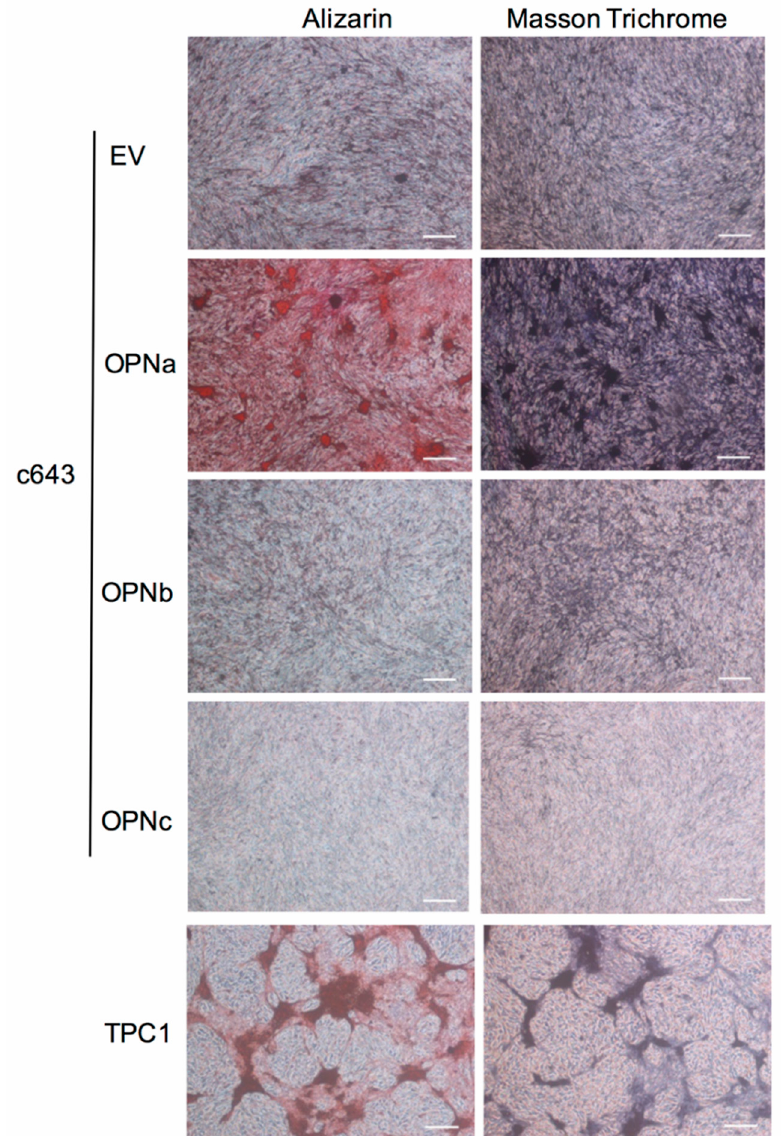
Figure 2. Calcification and collagen production in c643 cell clones and TPC-1 cell line. Left panel : c643 cell clones overexpressing OPNa, OPNb, or OPNc, as well empty (EV) controls were analyzed ( Left panel ) for matrix calcification by Alizarin Red staining, in which darker orange areas represent extracellular matrix (ECM) areas rich in calcium deposits. Right panel : c643 cell clones and TPC-1 cells were analyzed for collagen deposits by Masson trichrome staining. Dark purple areas correspond to extracellular matrix rich in collagen. Scale bar: 100 µM. Representative photomicrographs of two independent experiments at 24 days of cell culture are shown.